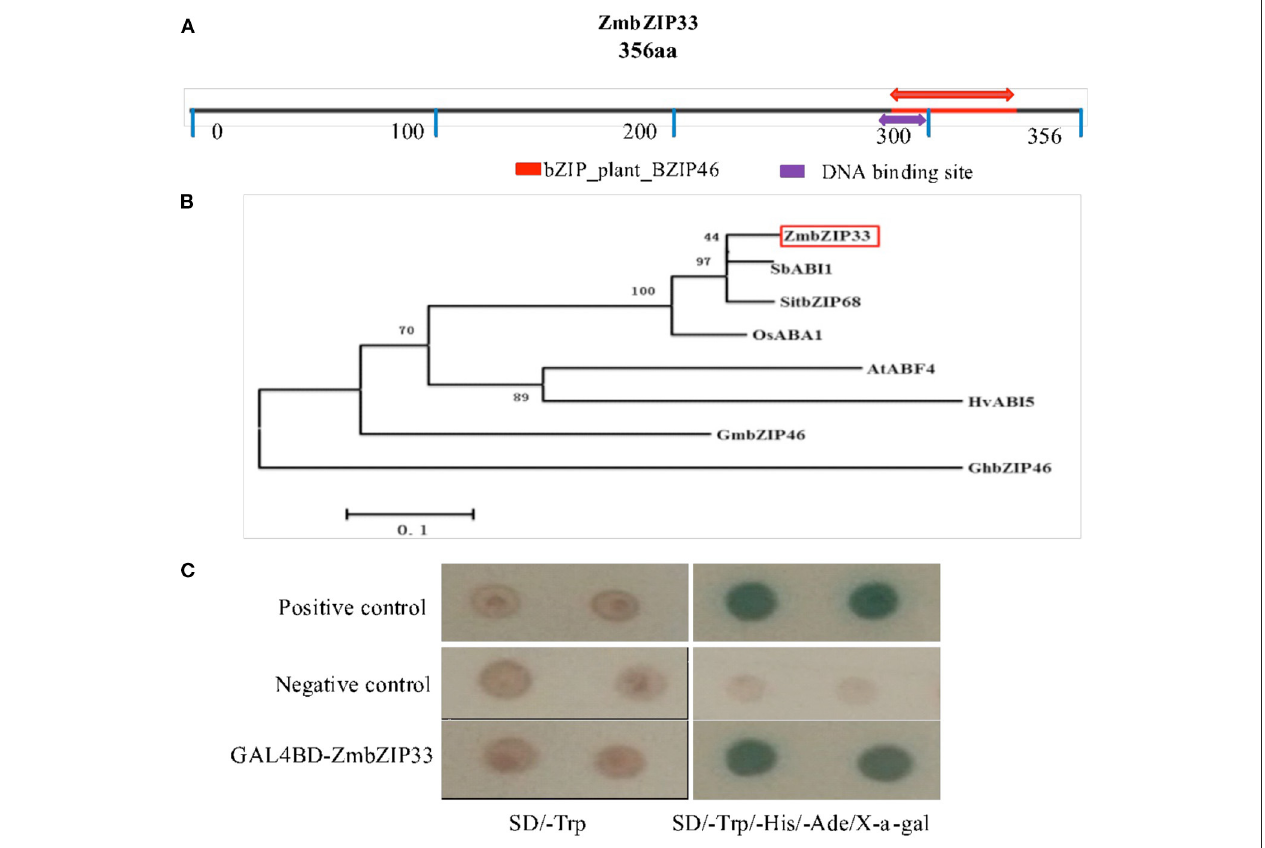
FIGURE 4 | Characterization of ZmbZIP33 gene. (A) The length of amino acid encoded by ZmbZIP33 gene and its domain. (B) Relationships between ZmbZIP33 and its homologs. Phylogenetic tree was generated using MEGA6 version (C) The construct pGBKT7- ZmbZIP33 was transformed into yeast strain AH109 and checked on SD/Trp and SD/Trp-/His-/Ade-/X- α -gal plates. pGBKT7-53 and pGADT7-T were used as a positive control, and pGBKT7 vector was used as a negative control.